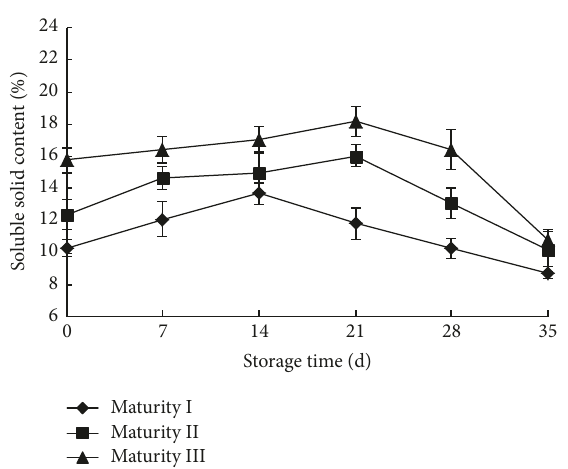
Figure 6: Effects of harvest maturity on ASA content in apricots; fruits with maturity class I (colored area < 50%), maturity class II (colored area 50–80%), and maturity class III (colored area > 80%) were categorized according to the yellow conversion rate. Vertical bars represent the standard errors of the means of triplicate replicates.